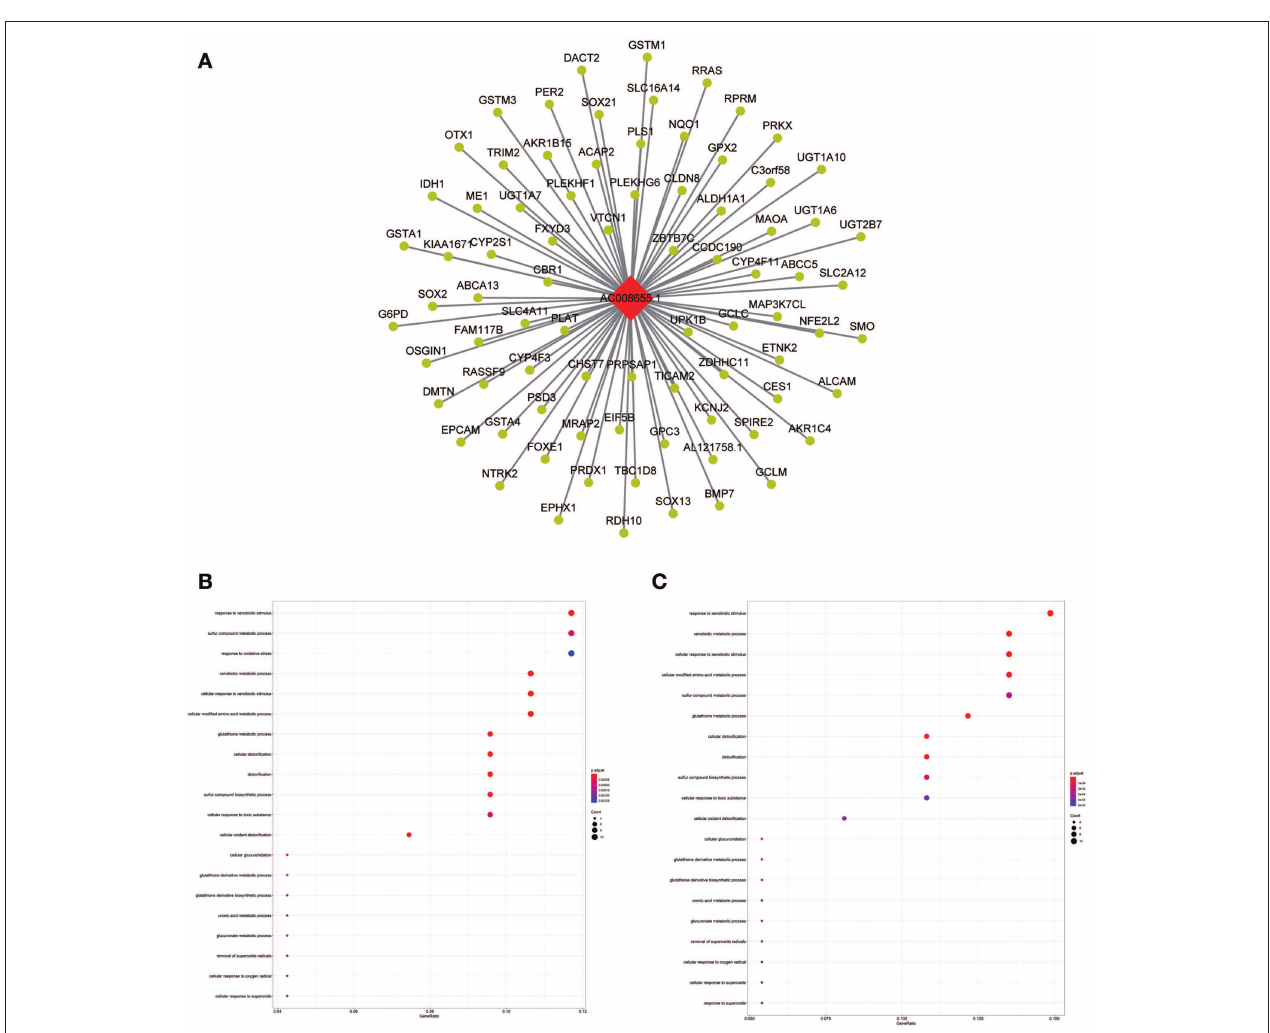
FIGURE 8 | LncRNA-mRNA network in Tan module and functional enrichment. (A) The lncRNA-mRNA network in Tan module, (B) GO-BP enrichment analysis (All genes in Tan module), and (C) GO-BP enrichment analysis (AC008655.1 related genes in Tan